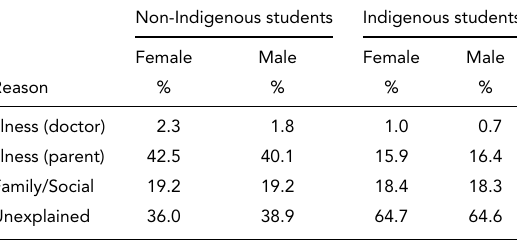
Percentages of Absences by Reason, Aboriginality and Sex 1997 Non-Indigenous students Indigenous